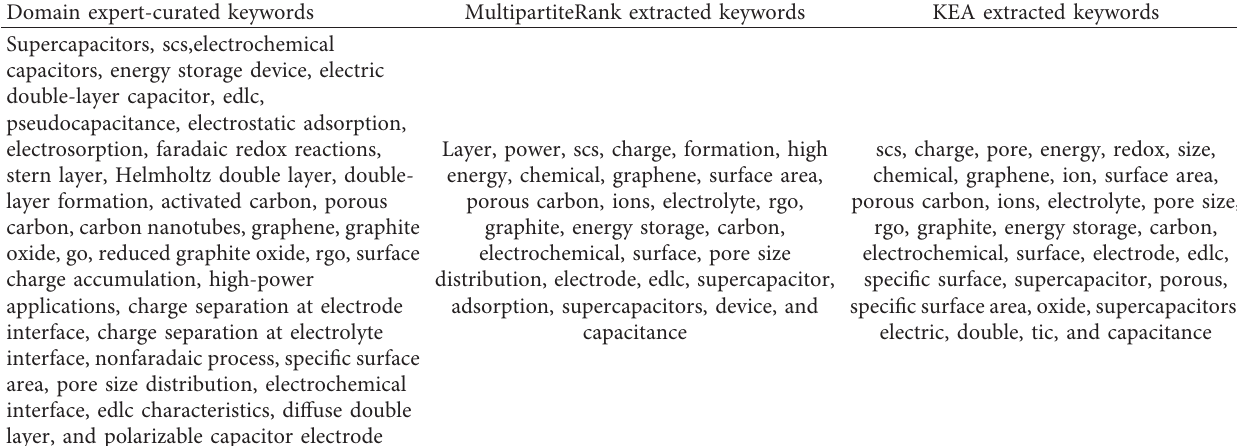
Table 5: Sample keywords extracted by MultipartiteRank, KEA keyword extraction techniques, and domain expert-curated keywords. Domain expert-curated keywords MultipartiteRank extracted keywords KEA extracted keywords